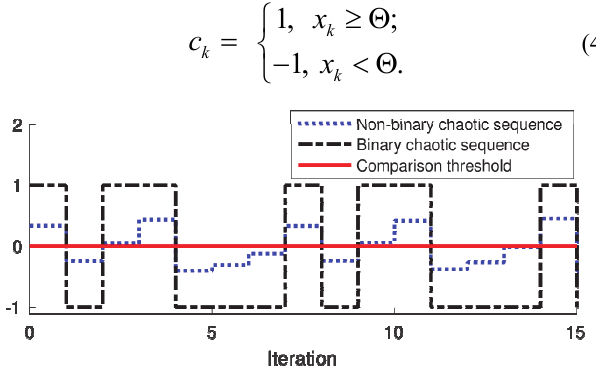
Fig. 2. Conversion of chaotic sequences into binary form .